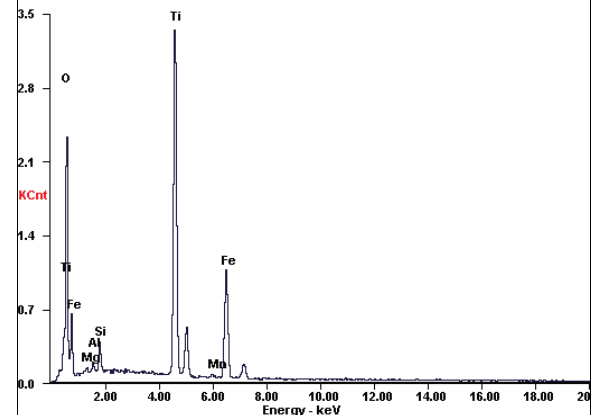
At 1123 K, anatase TiO 2 transforms to rutile TiO 2 as shown in Eq. (4) [18] Figure 4. EDAX spectra of titania slag.